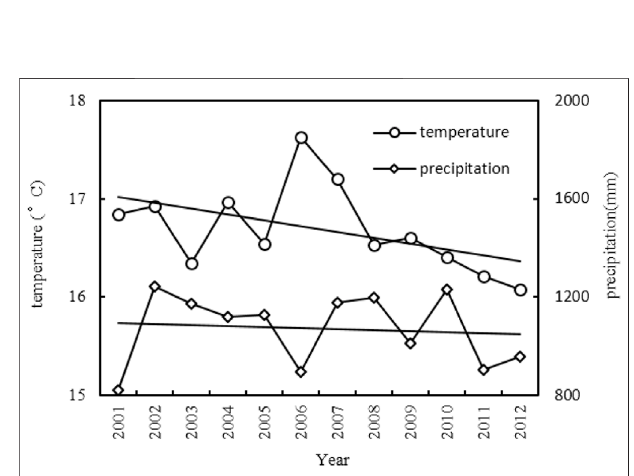
FIGURE 13 | Inter-annual variations of temperature and precipitation of Hubei Province from 2001 to